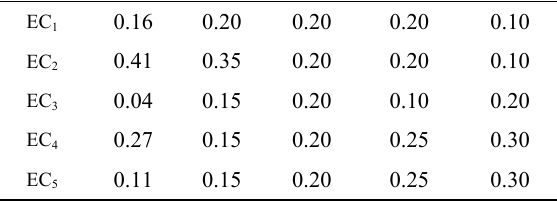
Table 12 – Closeness coefficients of the strategic alternatives with respect to the considered cases Strategic